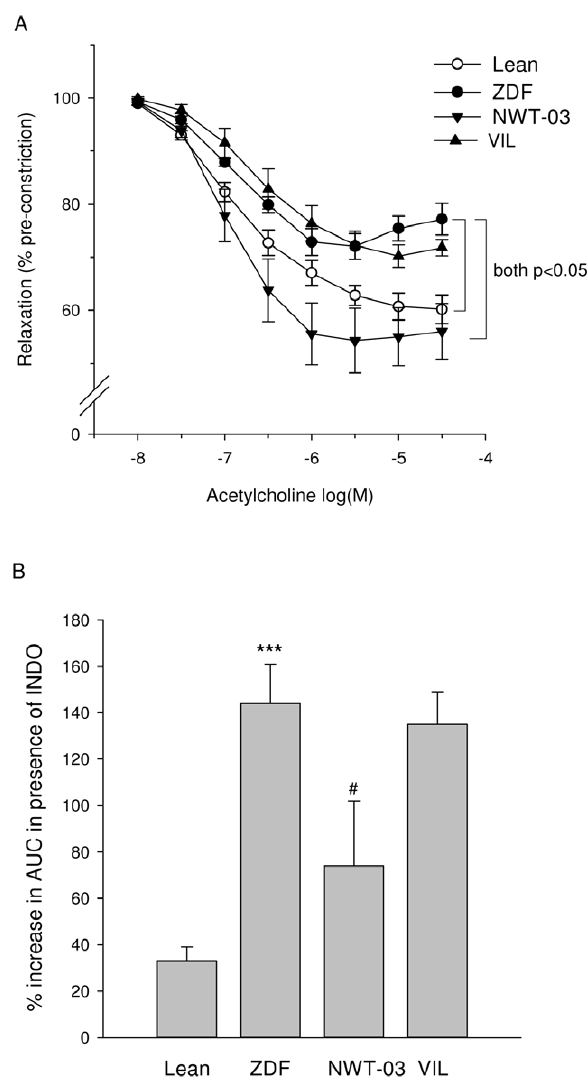
Figure 5. EDR response to ACh in isolated aortic rings. (A) ACh- induced relaxation in untreated ZDF rats was significantly reduced compared to that in lean controls. Relaxations were significantly increased in ZDF rats supplemented with NWT-03, but not in those treated with VIL. Pre-incubation with the COX-inhibitor indomethacin (INDO) profoundly improved relaxation to ACh in untreated ZDF rats (not shown in panel A; see lean vs. ZDF in panel B). The area under the curve (AUC) for ACh-induced relaxation in the absence and presence of INDO was determined for each group and used to calculate the percentage improvement. Data are means 6 SEMs; significant differences are as indicated (repeated measures ANOVA). (B) Acute COX inhibition improved ACh-induced relaxation to a significantly smaller extent in ZDF rats supplemented with NWT-03, indicating a diminished suppression of relaxation by contractile PGs in the latter rats. Data are means 6 SEMs (***p , 0.001 vs. lean; # p , 0.05 vs. ZDF).